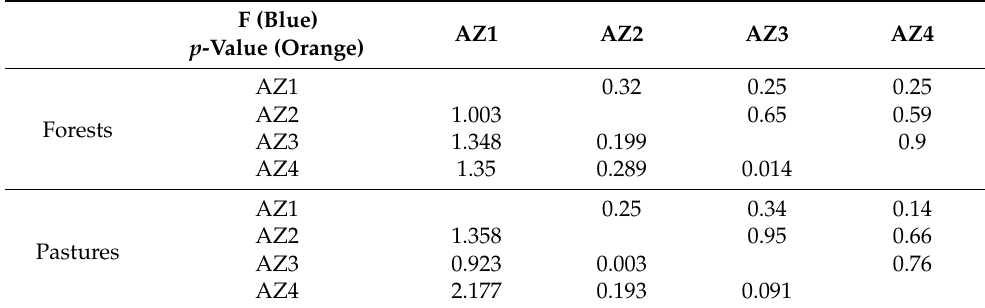
Figure 4. Scatter plots relating MaxNDVI ( × 10,000) to the years (2001–2019) where regression lines for forests and pastures AZs classes are reported as well. Table 10. F-statistic (blue) and p -value (orange) resulting from common slope test for Forests and Pastures CLC